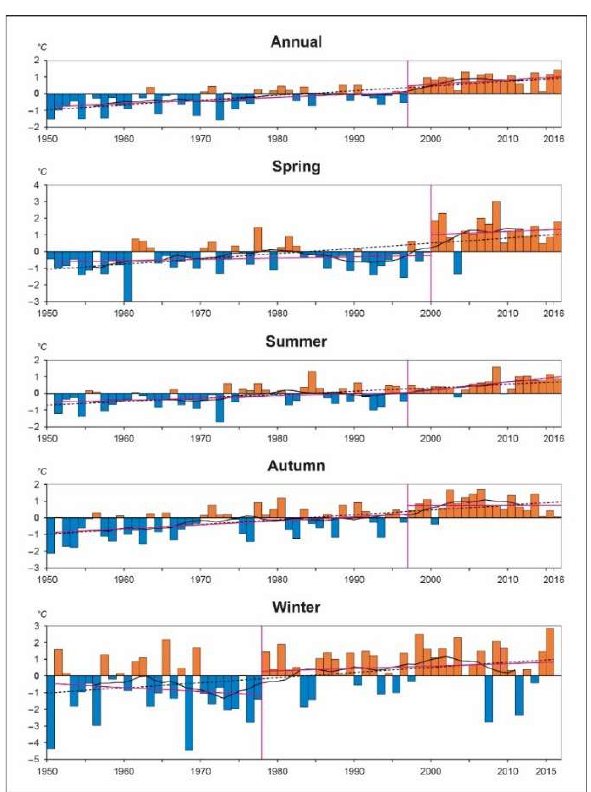
Figure 4. Seasonal and annual temperature anomaly time series from 1950–2016 for the research area. The solid black line is the 10-year moving average line and the dashed black line the linear trend. The pink lines show the year of the change point and the trend direction before and after the change point.